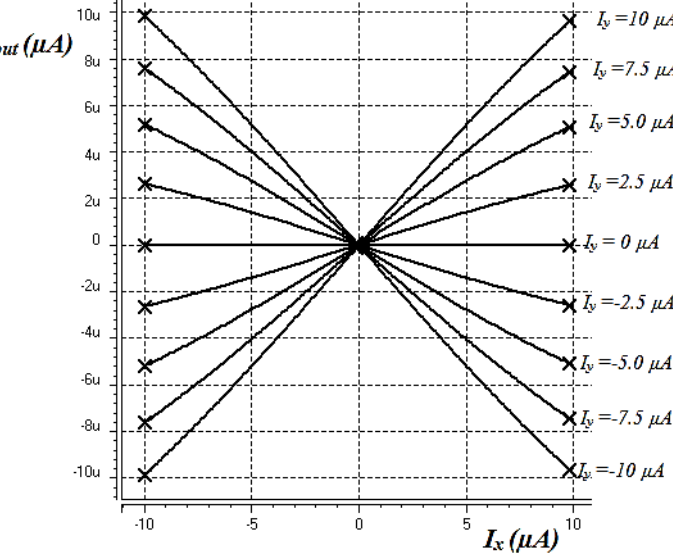
Figure 6. Offset canceled DC transfer characteristics